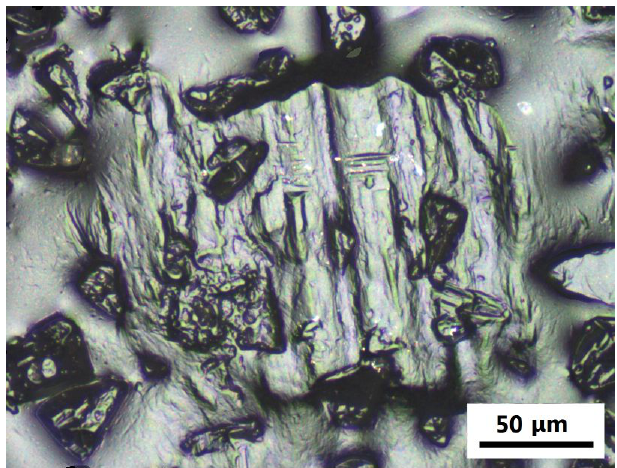
Figure 3. Sticking area on grinding-wheel AS visible on its